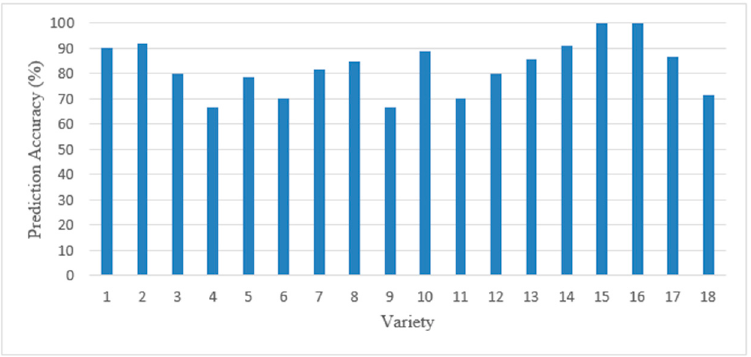
Figure 5. The prediction accuracy (percentage) of each of the 18 varieties in response to the classification model.